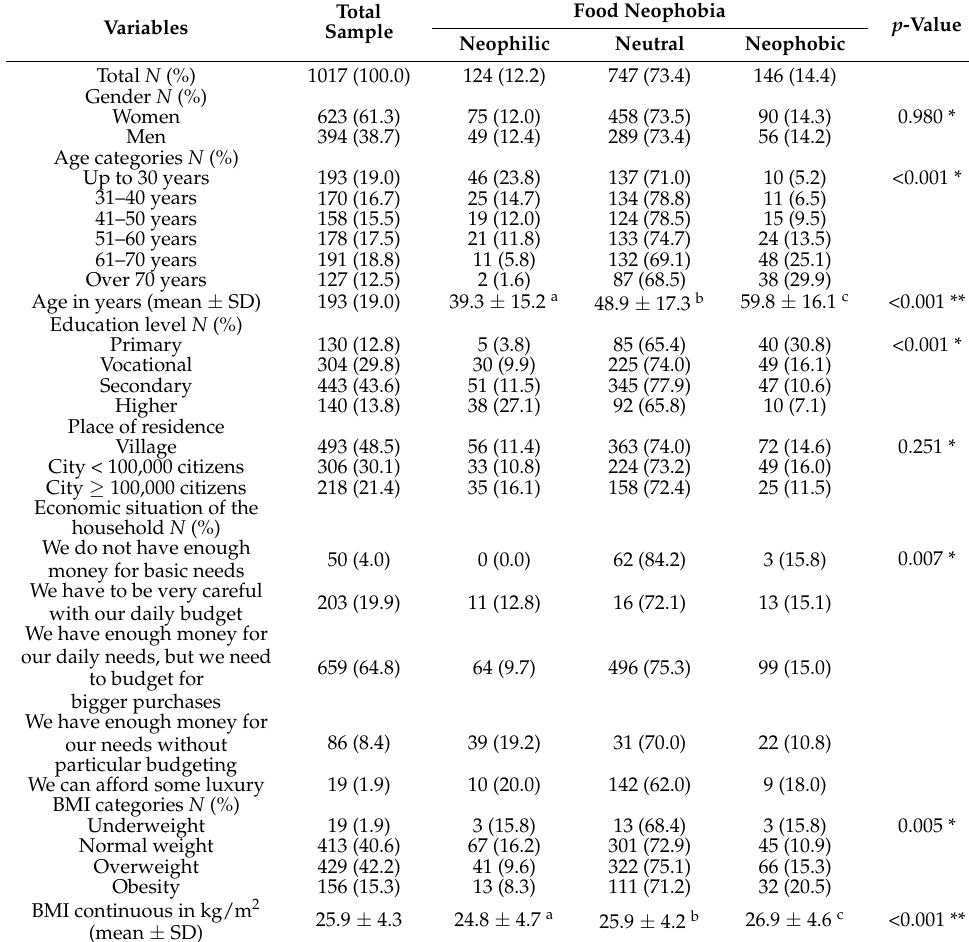
Table 3. Characteristics of the sample according to the level of food neophobia ( N =